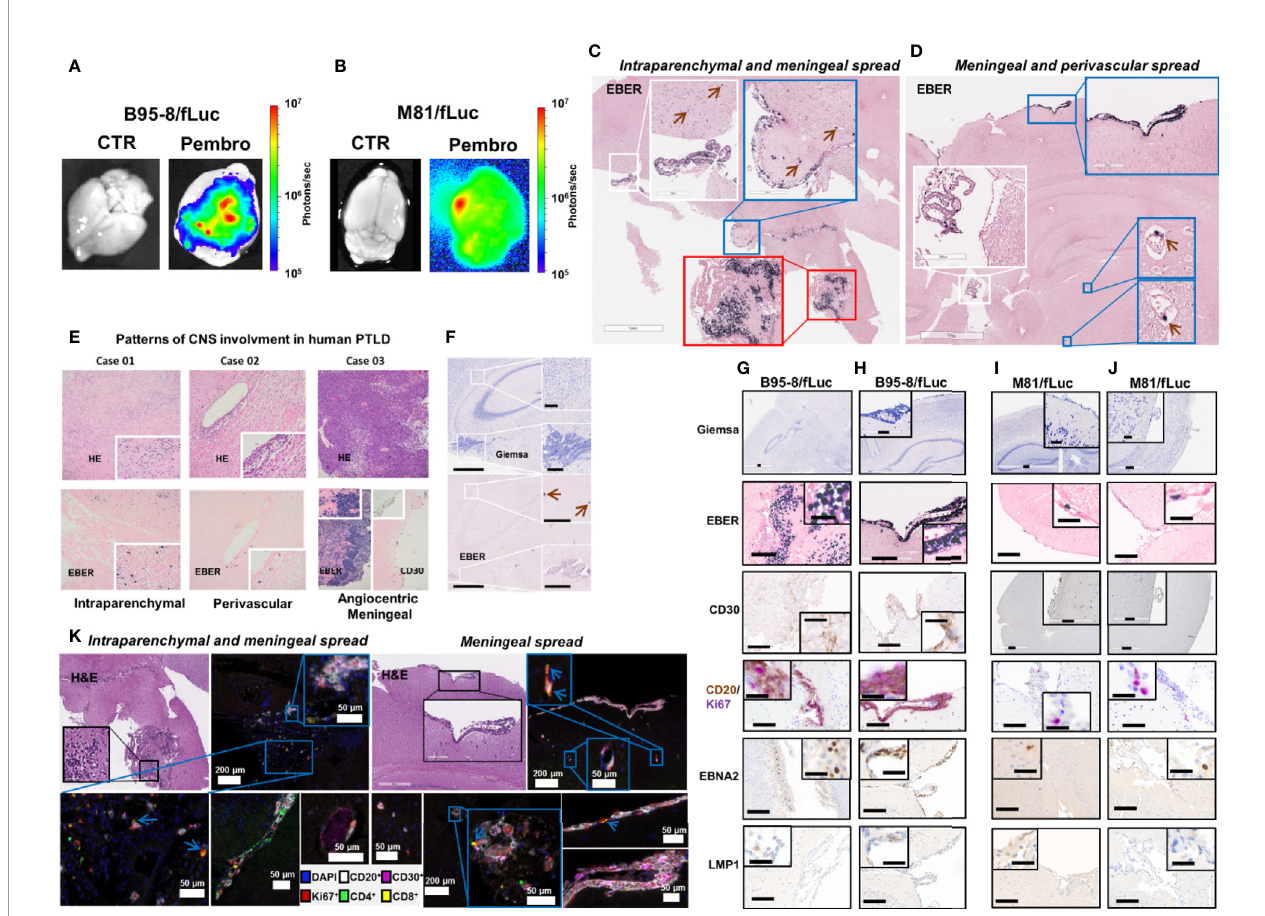
FIGURE 3 | Pembrolizumab treatment is associated with spread of EBV/fLuc to the central nervous system. (A, B) Bioluminescence images showing representative EBV signal patterns in brains from mice infected with B95-8/fLuc (A) or with M81/fLuc (B) and treated with pembrolizumab (Pembro; most severely affected animals shown in each group), compared with non-treated controls (CTR). The bioluminescence signal intensities (photons/sec) are depicted by the color bar on the right side. (C, D) In-situ hybridization for detection of Epstein-Barr encoded RNA (EBER)-1 in brains of mice infected with B95-8/fLuc and treated with pembrolizumab. Observed patterns include invasion of tumor cells into the plexus choroideus (white inserts), as well as into periventricular brain parenchyma (red insert) and meningeal tumor spread (blue inserts). The green arrows indicate single tumor cells associated with blood vessels. (E) Comparison with three representative examples of human EBV-positive monomorphic transplantation-associated B-PTLD, with clinical manifestation as primary CNS lymphoma (PCNSL) revealed similar patterns of intraparenchymal (Case 01), perivascular (Case 02), and massive angiocentric/diffuse growth with meningeal spread (Case 03). (F) Control animals did not show any involvement of the plexus choroideus or periventricular brain areas. Only single EBER-positive cells in intravascular localization were detected (green arrows). (G – J) The immunophenotype of the neoplastic cells invading the brain of ICI-treated mice corresponded to the phenotype of the peripheral neoplastic population with variable CD30 + , and constant CD20 + expression. The majority of neoplastic cells expressed EBNA2 but not LMP1 and were actively proliferating (CD20 + /Ki67 + ). (G – H) and (I – J) Analyses of duplicate mice infected with B95-8/fLuc and M81/fLuc and treated with pembrolizumab, respectively. (K) Multiplexed image of two mouse brains from B95-8/fLuc infection model after pembrolizumab treatment con fi rmed co-localization of neoplastic cells (CD20 + , white; CD30 + , magenta) and T lymphocytes (CD8 + yellow; CD4 + , green). Lymphocytes were actively proliferating (Ki67 + , red), particularly CD8 (blue arrows). DAPI (blue) is used to mark cell nucleus. Bars correspond to 200 µm (full image) and 50 µm